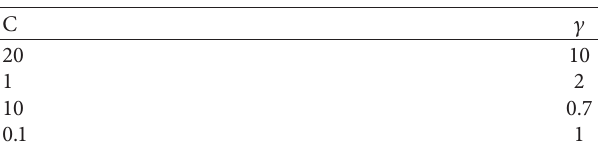
Figure 8: IPJAYA algorithm. Table 2: C and c values.